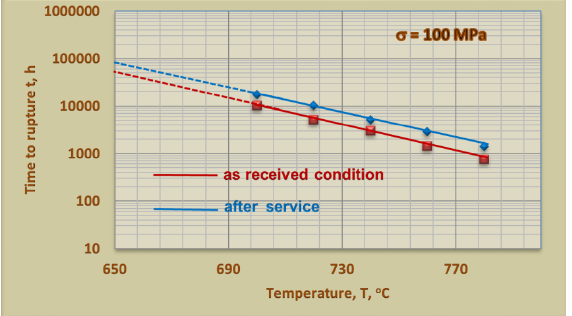
Figure 10. Results of short-term creep test of HR3C steel.